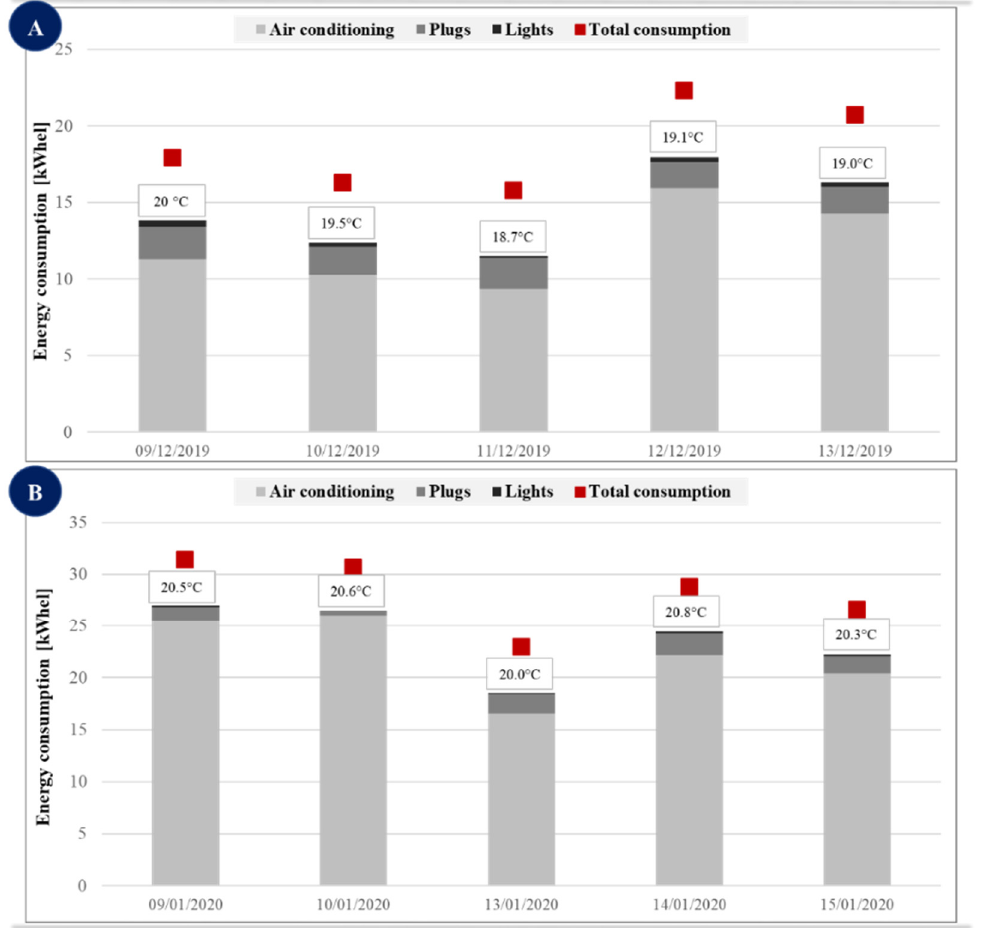
Figure 4. Energy consumption trend: ( A ) setpoint lower that 20 °C and ( B ) upper 20 °C.